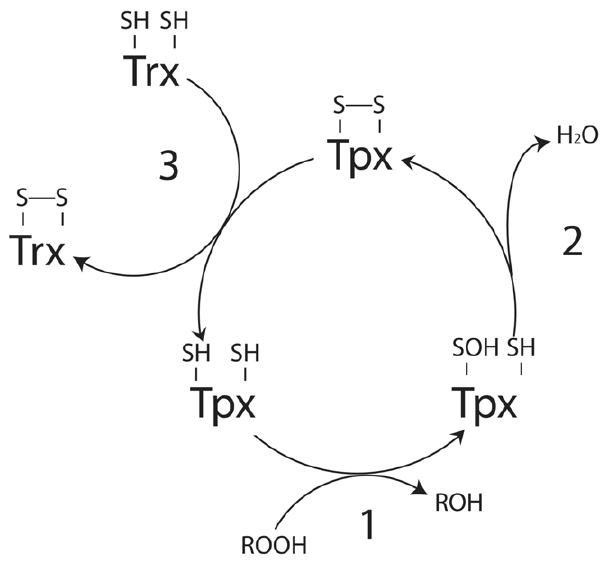
Figure 1. Redox cycle of Tpx. The reduction of ROS by oxidation (step 1) of Tpx producing H 2 O (step 2). The oxidised form (disulphide bond) of Tpx is recovered by thioredoxin (Trx), and returned to the reduced form (step 3).